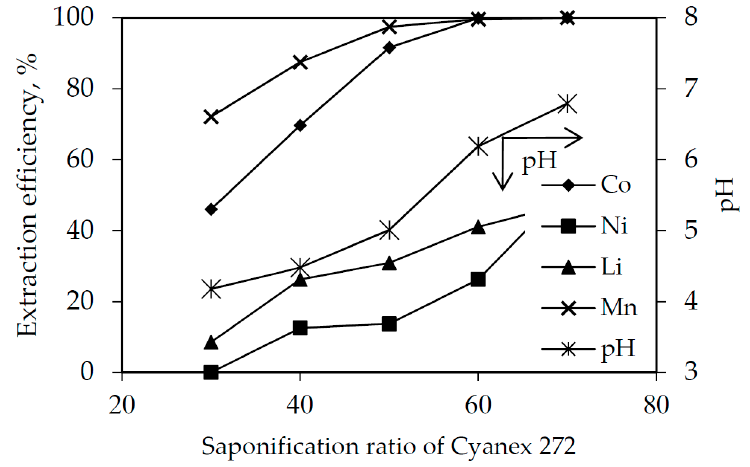
Figure 3. Effect of saponification% of 0.85 M Cyanex 272 on metal extraction and pH.